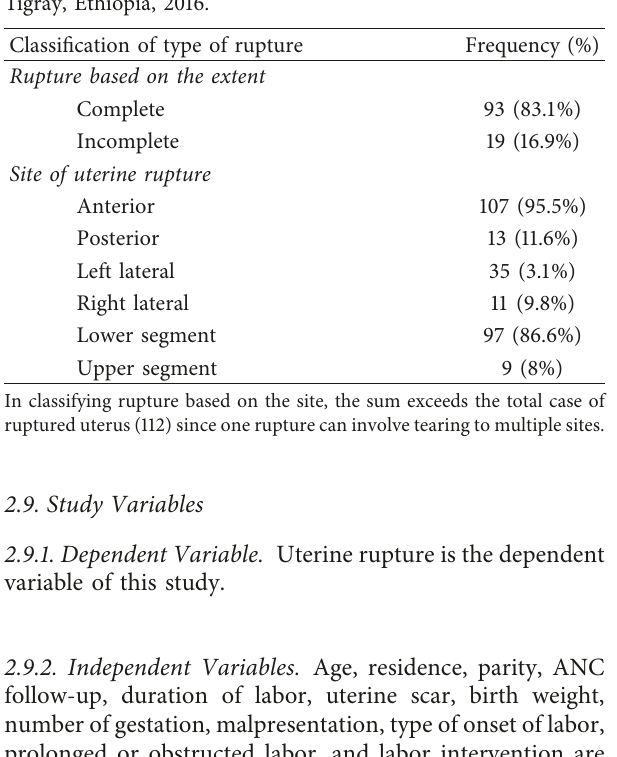
Table 1: Sociodemographic and obstetric characteristics of par- turient in Suhul General Hospital, Shire Town, North West Tigray, Ethiopia, 2016.